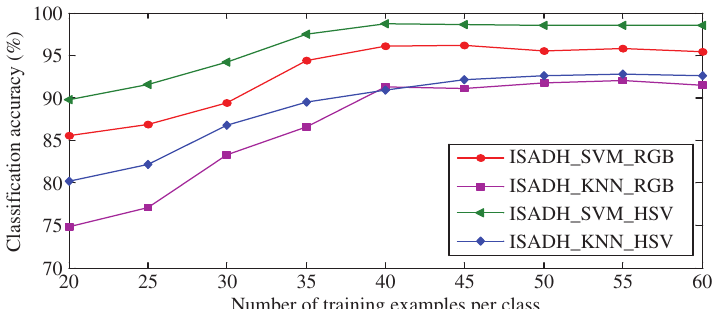
Figure 8. Comparison of SVM and KNN Classifier using the ISADH Texture Feature in Both the RGB and HSV Color Spaces for Fruit and Vegetable Classification Problem